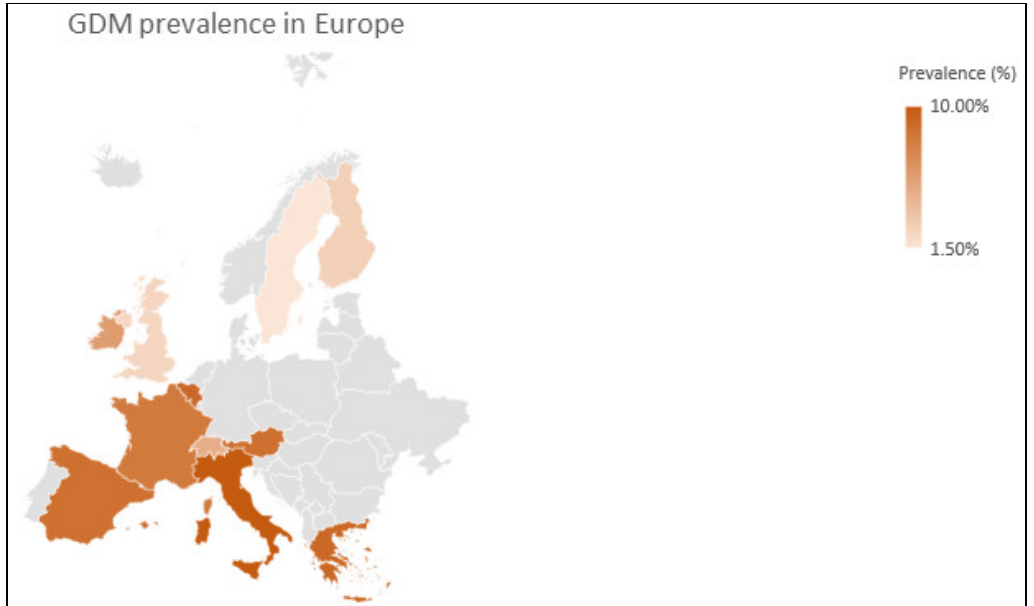
Figure 1. GDM prevalence in 11 European countries.